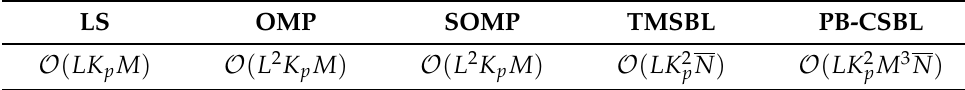
Table 1. The comparison of time